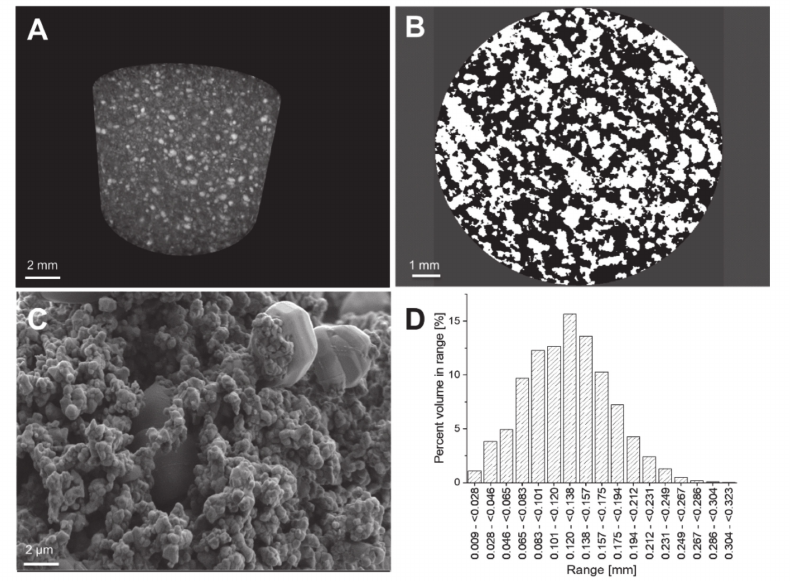
Figure 6. ( A ) Three-dimensional maximum intensity projection (MIP) of a BaTiO 3 / HA sca ff olds with visible particles of di ff erent densities (scale bar: 2 mm); ( B ) The binarised cross-sectional microCT images reveal the number of pores (black) and provide the basis for a 3D calculation of porosity (scale bar: 1 mm). ( C ) The SEM images underline the results visible in the microCT of a highly porous network of particles which are roughly sintered. Large particles of HA are embedded in a percolating network of BaTiO 3 particles through the whole sca ff old (scale bar: 2 µ m); ( D ) The pore size distribution of a 3D printed BaTiO 3 / HA sca ff old.